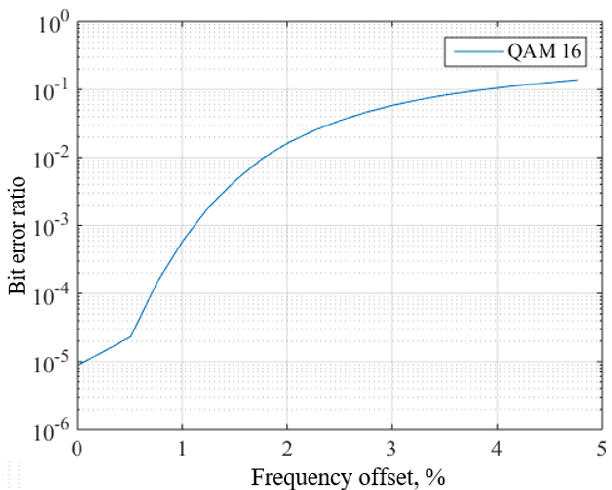
Fig. 6 . Dependence of the probability of bit error on the ratio of the frequency shift error value to the frequency interval between